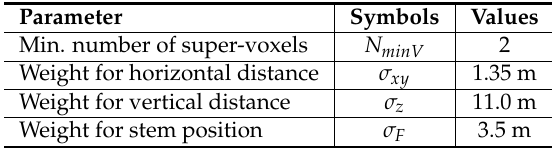
Table 5. Control parameters of single tree segmentation.